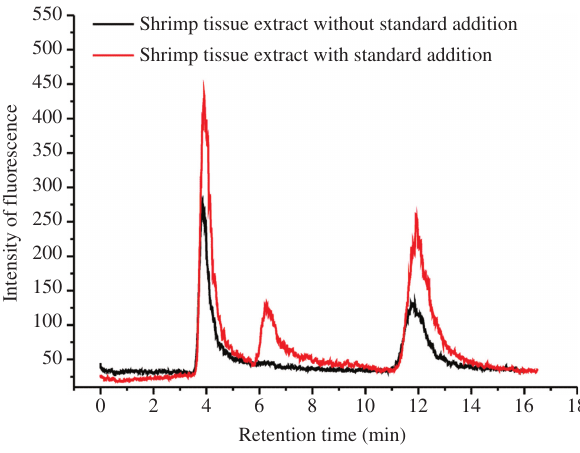
Figure 3 Schematic of the setup of mini-DBD used in Hg vapor generation. Reproduced from Wu et al. (2011) with permission of the Royal Society of Chemistry.